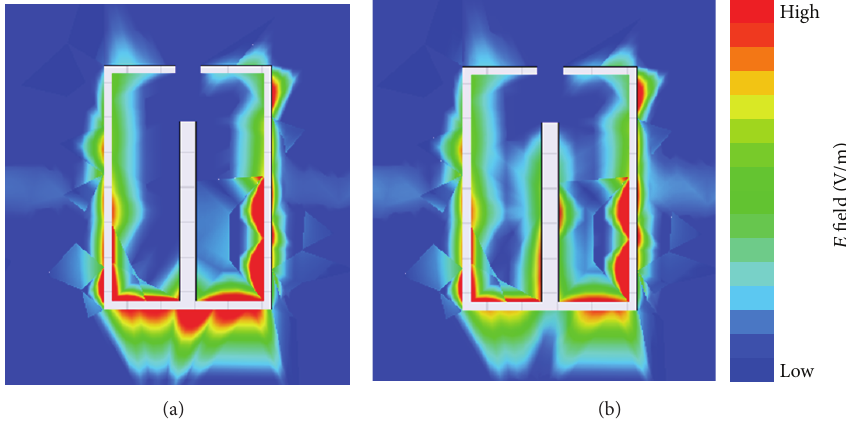
Figure 3: Simulated electric field distributions at two resonant frequencies of DSLR: (a) mode I and (b) mode II.